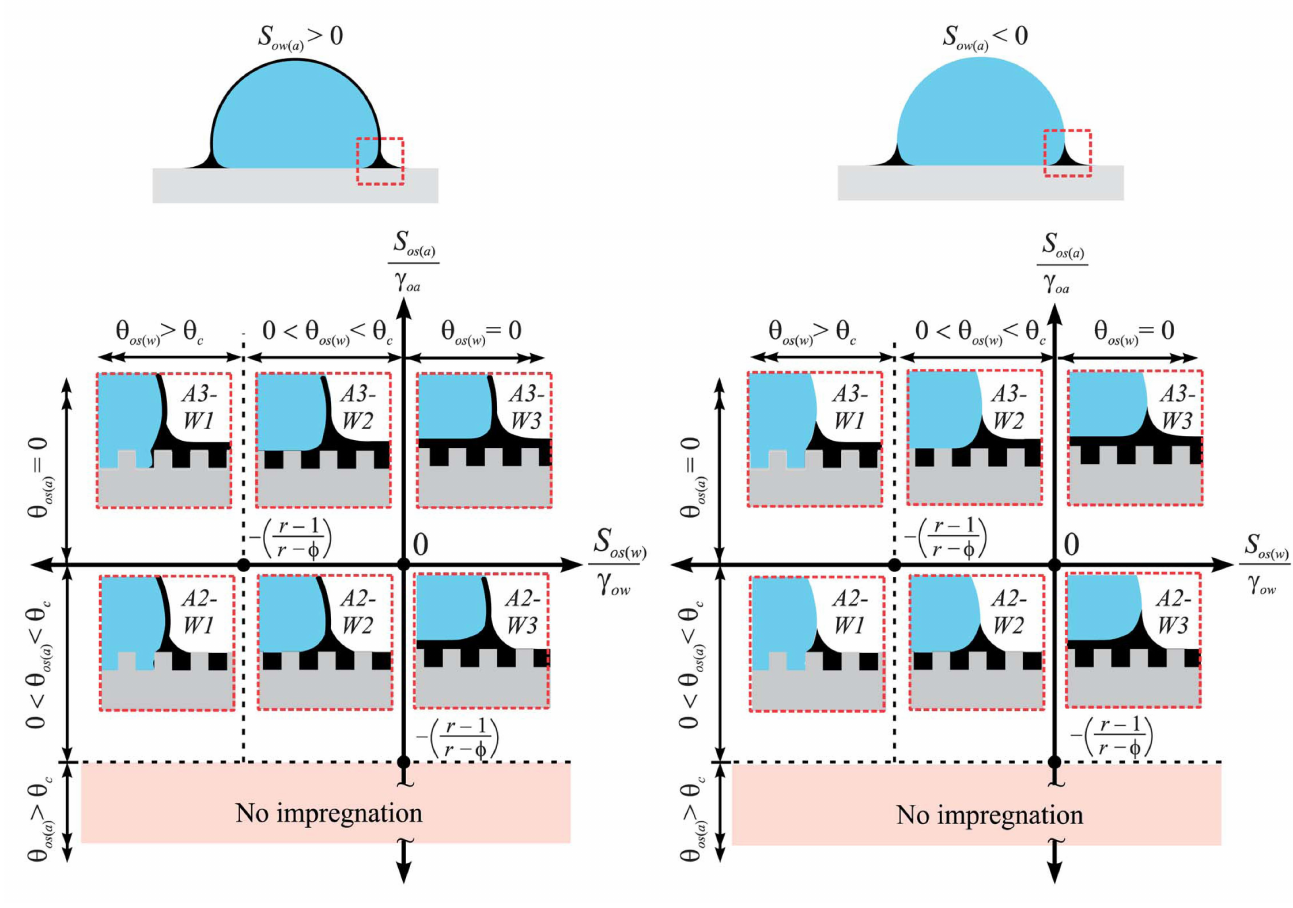
Figure 41. Possible thermodynamic states of water droplet placed on lubricant-impregnated surface. The top two schematics show whether or not the droplet gets cloaked by lubricant. For each case, there are six possible states depending on how the lubricant wets texture in presence of air (vertical axis) and water (horizontal axis). From Smith et al.